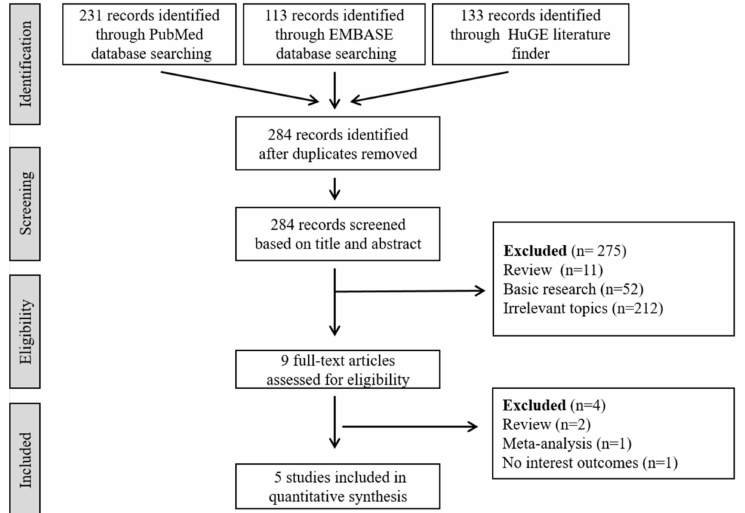
Figure 1. Flow chart of the systematic review of previous genetic / genome-wide association